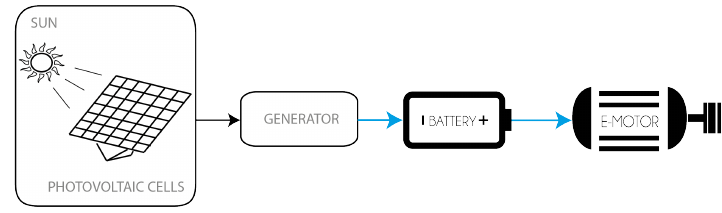
Figure 9. A diagram of the configuration of